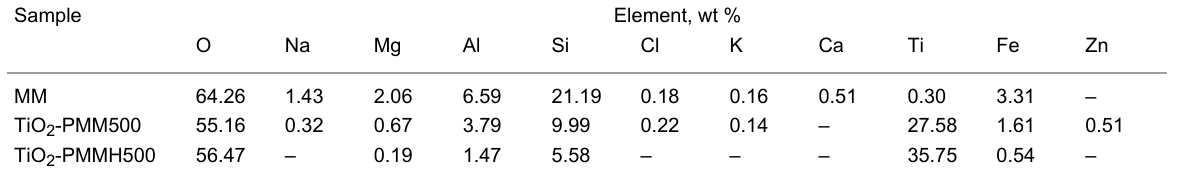
Table 4: Elemental analysis of the MM, TiO 2 -PMM500, and TiO 2 -PMM Н 500 samples. Sample